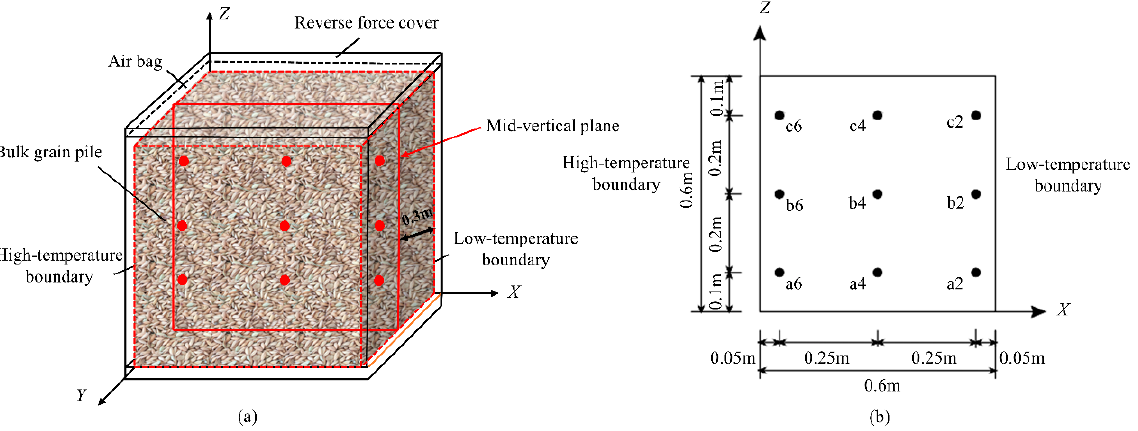
Figure 1. The test chamber: ( a ) Main diagram of test chamber; ( b ) Main view of the test chamber.